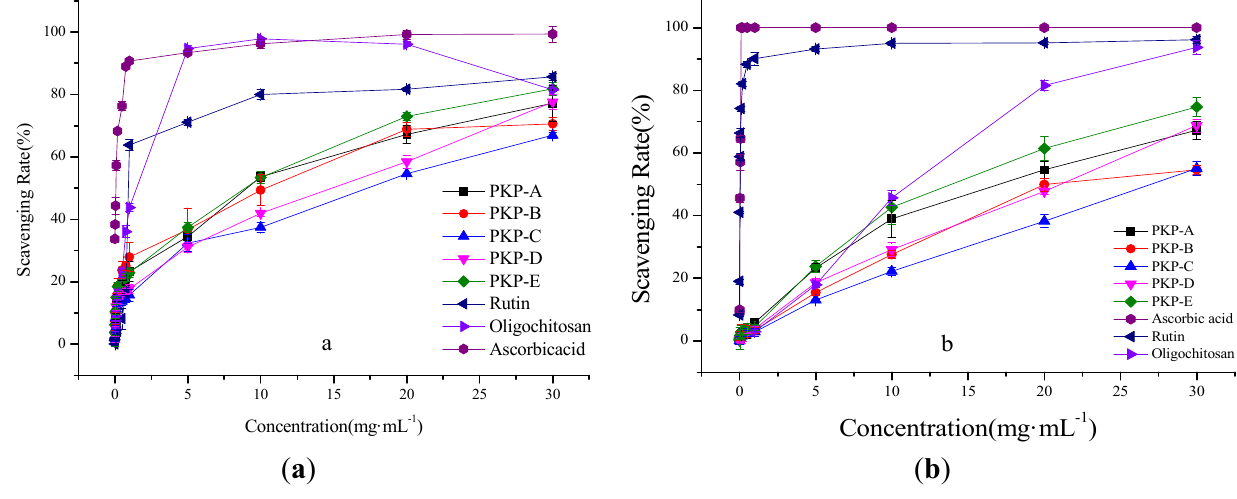
Figure 4. The in vitro antioxidant activity of the five fractions from pine